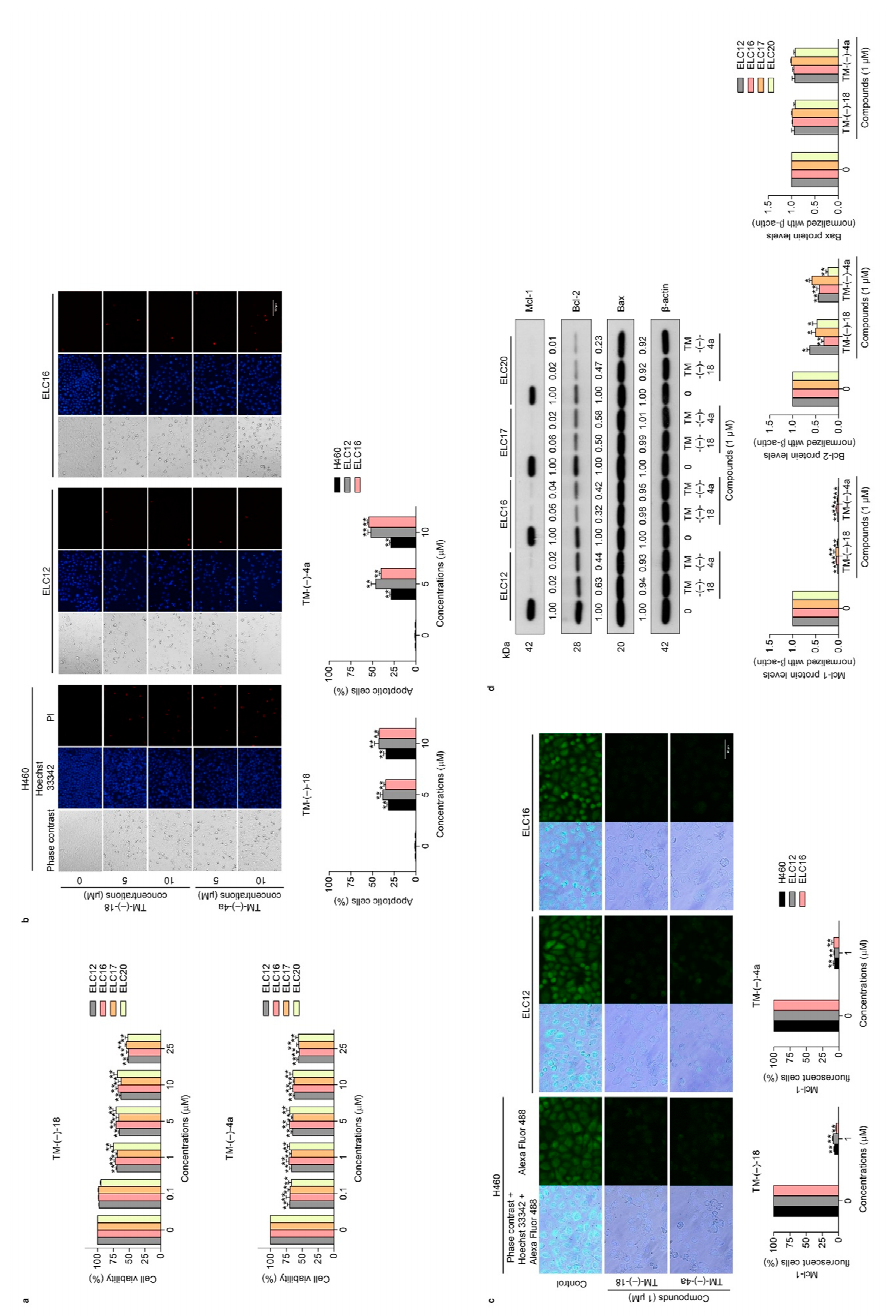
Figure 4. E ff ects of the simplified right-half model of RT compounds: TM-(–)-18 and TM-(–)-4a on cell viability, apoptotic induction, and apoptotic-related protein expressions in patient-derived primary cancer cell lines (ELC12, ELC16, ELC17, and ELC20). ( a ) ELC12, ELC16, ELC17, and ELC20 cells were seeded and treated with 0–25 µ M of TM-(–)-18 and TM-(–)-4a for 24 h. Then, the MTT assay was performed to determine the percentages of cell viability. ( b ) H460, ELC12, and ELC16 cells were seeded and treated with 0–10 µ M of TM-(–)-18 and TM-(–)-4a for 24 h. Hoechst 33342 and PI were added and then the images were visualized using a fluorescence microscope. ( c ) H460, ELC12, and ELC16 cells were seeded and treated with 0–1 µ M of TM-(–)-18 and TM-(–)-4a for 24 h before performing immunofluorescence using the Mcl-1 primary antibody. Alexa Fluor 488 conjugated secondary antibody and Hoechst 33342 were added and the images were visualized under a fluorescence microscope. ( d ) ELC12, ELC16, ELC17, and ELC20 cell lines were seeded and treated with 0–1 µ M of TM-(–)-18 and TM-(–)-4a for 24 h. Western blot analysis was performed to detect the Mcl-1, Bcl-2, and Bax protein levels. The blots were reprobed with β -actin to confirm an equal loading of each of the protein samples and densitometry was used to calculate the relative protein levels. Densitometric values of protein expression levels were presented as the fold changes relative to β -actin. Data represent the mean ± SEM ( n = 3) (* 0.01 ≤ p < 0.05, ** p < 0.01, compared with the untreated